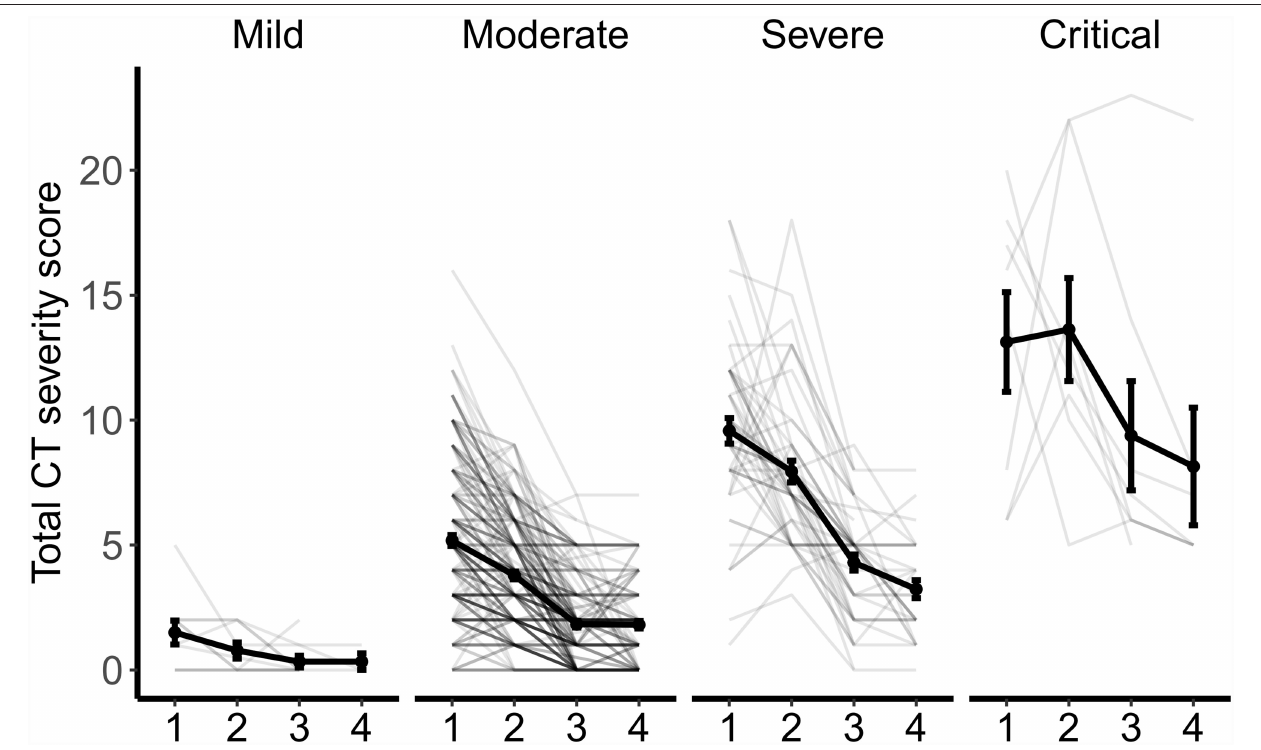
FIGURE 2 | Dynamic Changes in CT scores and the number of lobes involved by disease severity. The point and error bar show the average value and standard error of total CT score at four timepoints from admission (1), to discharge (2), to 3 months (3), and 6 months (4) follow-up.